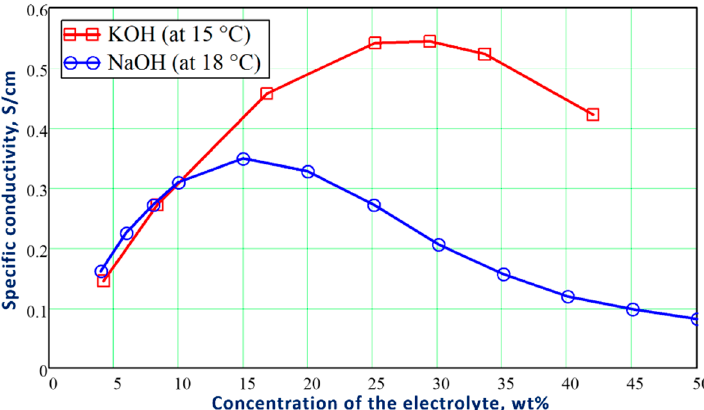
Figure 1. Influence of the weight concentration of KOH and NaOH on the specific conductivity of their aqueous solutions at 15 °C and 18 °C, respectively. The diagram was built based on the tabular data presented in [27].